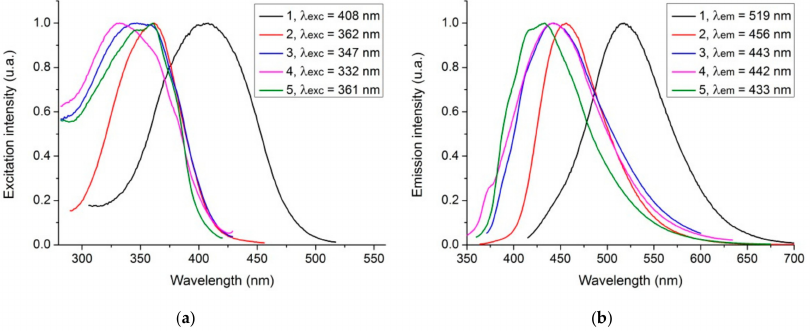
Figure 2. Fluorescence ( a ) Excitation spectra and ( b ) Emission spectra of the five CDs. Data were normalized to their